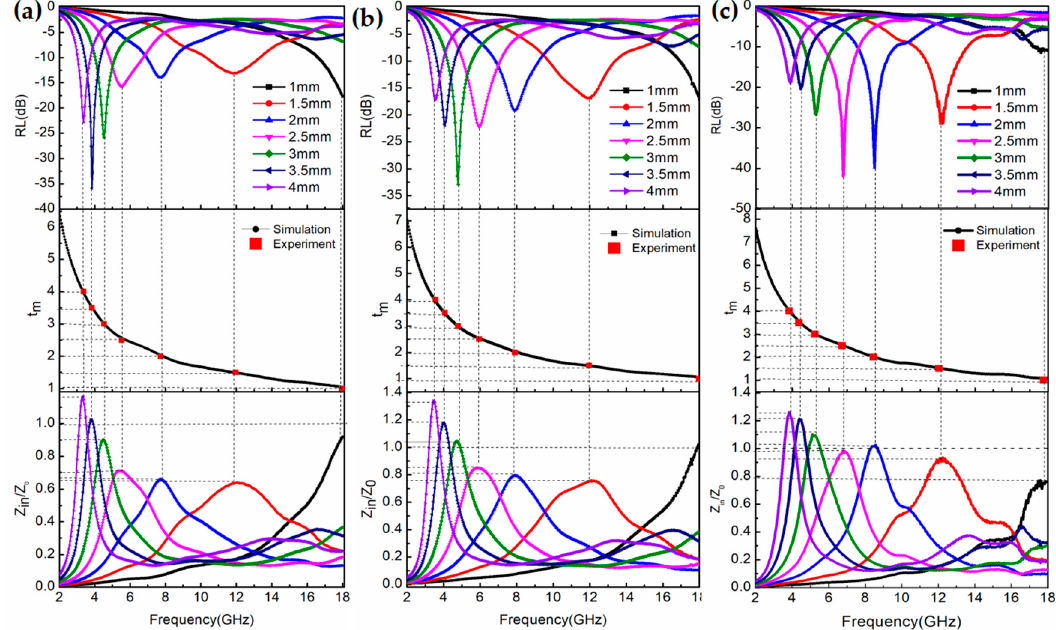
Figure 7. The reflection loss (RL) frequency curves, the relationship between the simulation thickness and the peak frequency, and relationship between Z in / Z 0 and the electromagnetic (EM) wave frequency of the hollow Fe 3 O 4 @0.5 g RGO composites ( a ), hollow Fe 3 O 4 @0.25 g RGO composites ( b ), and hollow Fe 3 O 4 @0.125 g RGO composites ( c ).